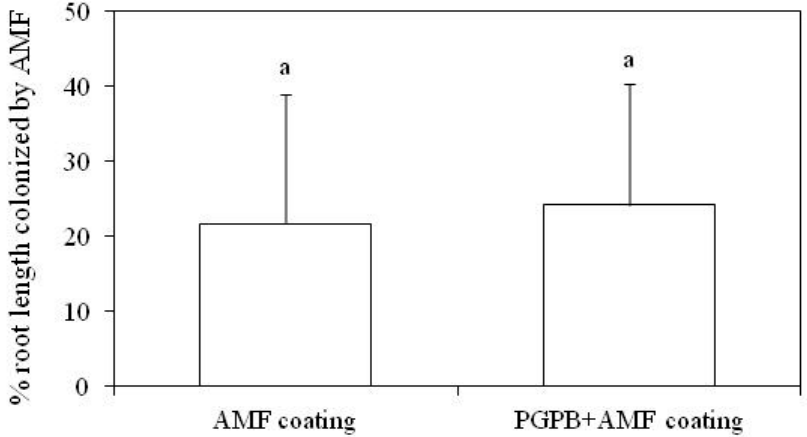
Figure 1. Percentage root length colonized (%RLC) in the roots of cowpea via seed coating. AMF, arbuscular mycorrhizal fungi; PGPB, plant growth promoting bacteria. Error bars represent standard deviation. Data of columns indexed by the same letter are not significantly different according to Tukey ′ s Honestly Significant Difference (HSD) test ( p < 0.05).